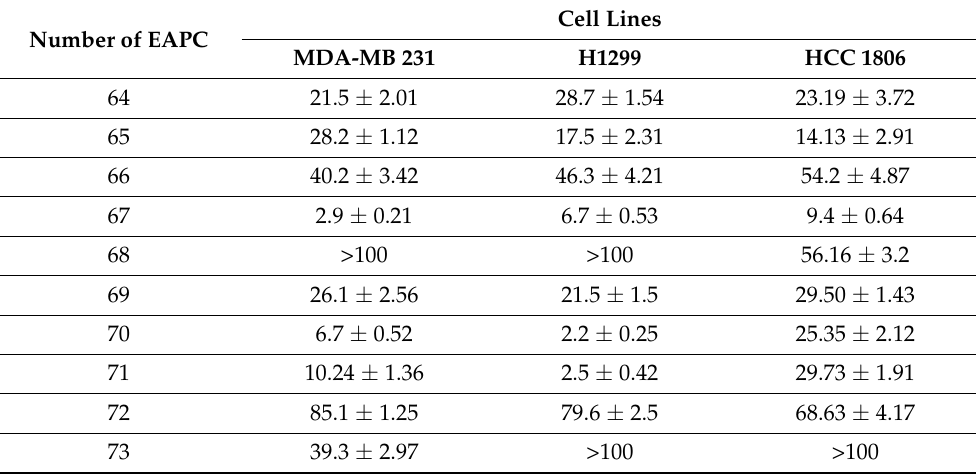
Table 1. IC 50 values (in the micromolar range) for EAPCs in HCC1806, MDA-MB-231 triple-negative breast cancer, and H1299 non-small cell lung cancer cell lines.